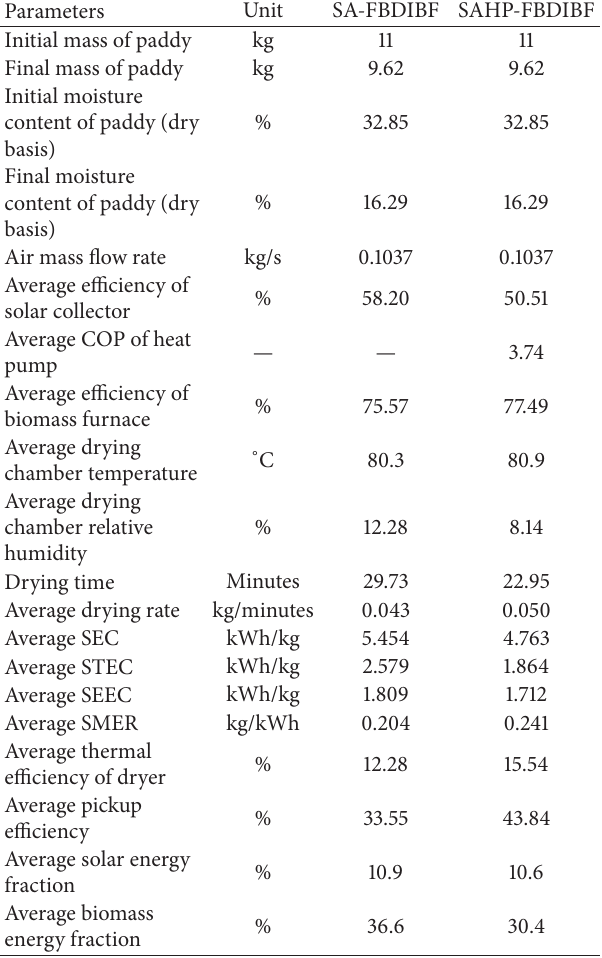
Figure 24: The variation of the energy fraction with drying time. Table 3: Performance evaluation of the SA-FBDIBF and SAHP- FBDIBF for drying of paddy.